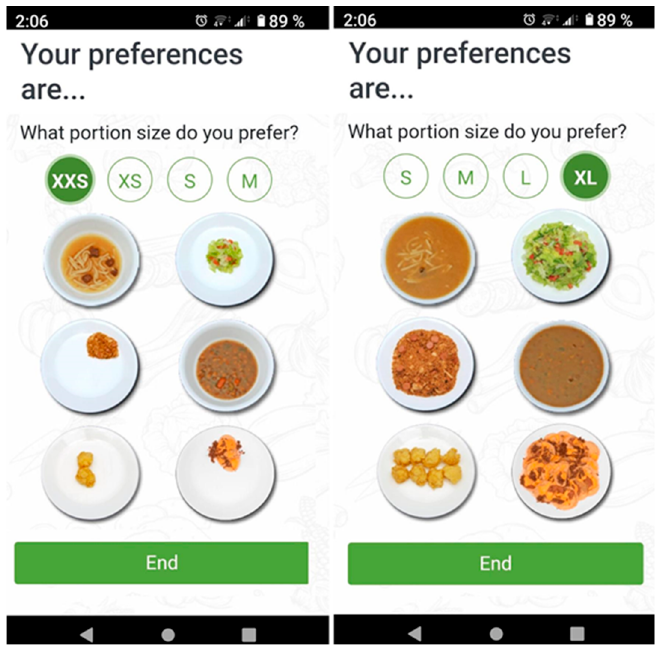
Figure 2. XXS and XL portion sizes of the APP.